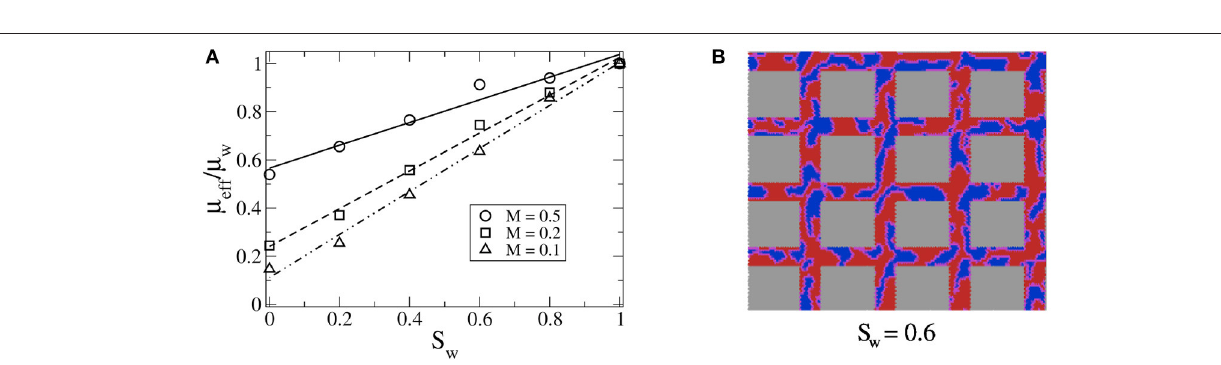
wetting fluid along the pore walls. This introduces a third regime with a negative value of α . The results are shown in Figure 6 which indicate a robust α over a range of M values. This means that, due to the